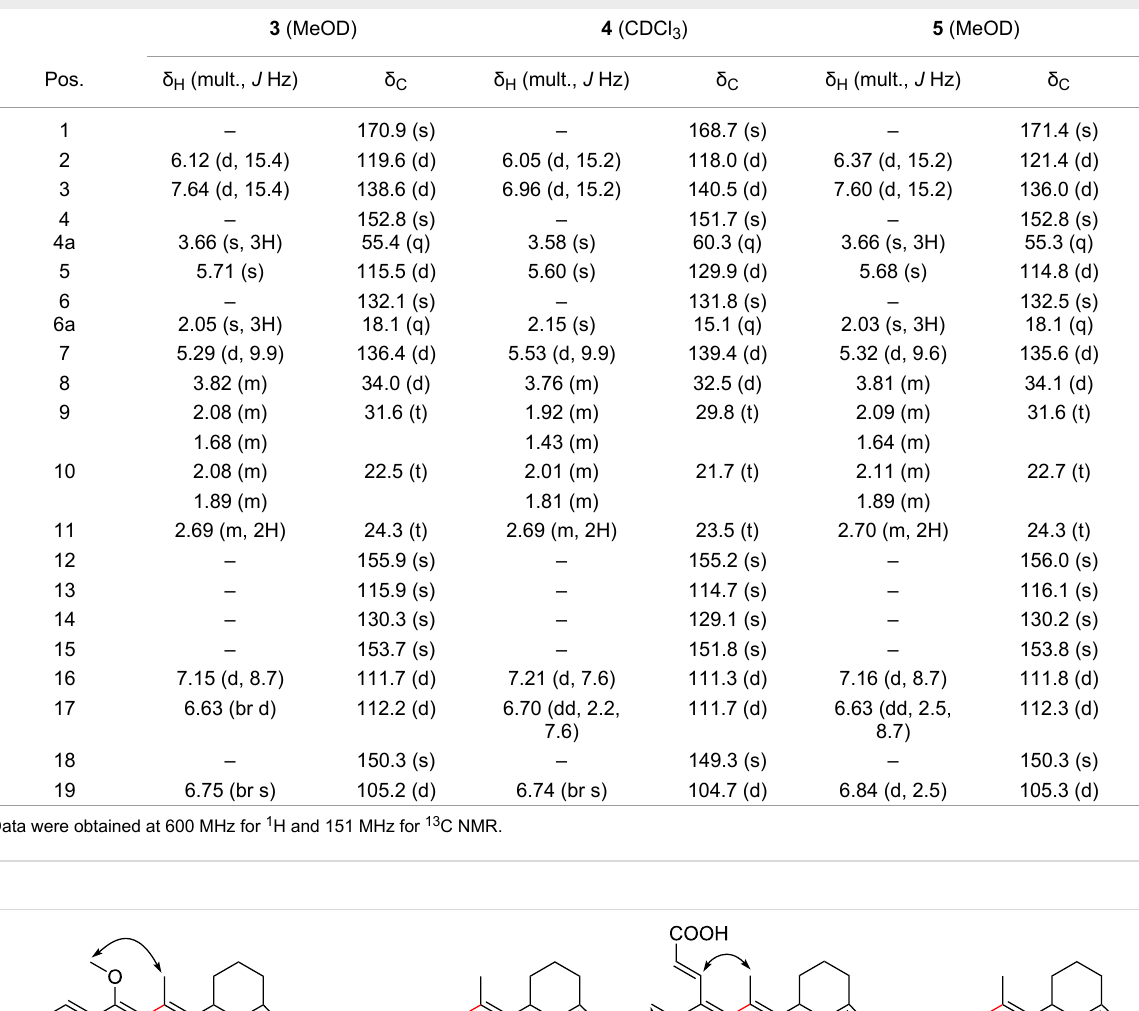
Table 1: 1 H and 13 C NMR spectroscopy data for compounds 3 , 4 and 5 a .